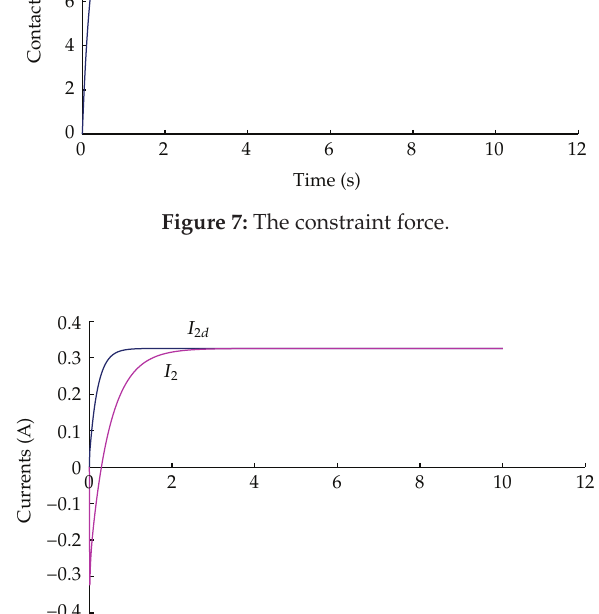
Figure 6: The input voltages.